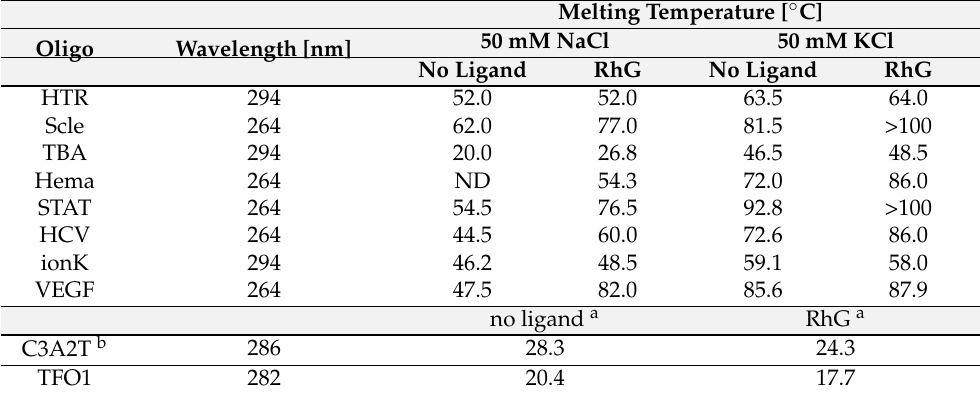
Figure 3. Representative CD spectra of DNA sequences able to adopt different non-canonical structures. The concentration of DNA and ligand was 27 and 130 µM (~1:5 eqv.), respectively, in each measurement. ICD signals are highlighted with colored circles. The mBR contains 50 mM NaCl. The positive and two negative peaks are observed at ~510, ~540 and ~570 nm, respectively. Table 1. Selected melting temperatures obtained using CD